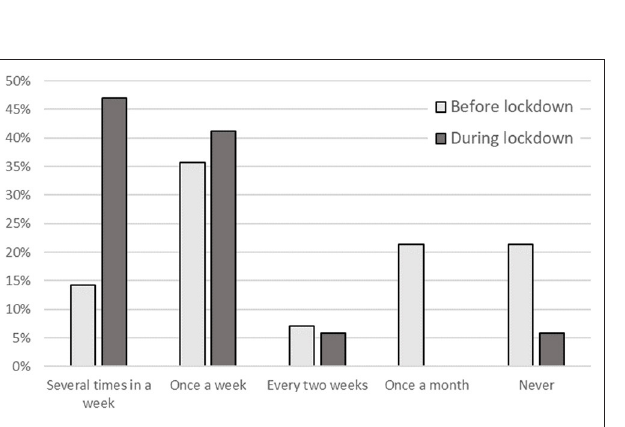
FIGURE 3 | Histogram of the amount of general sports activities by measuring